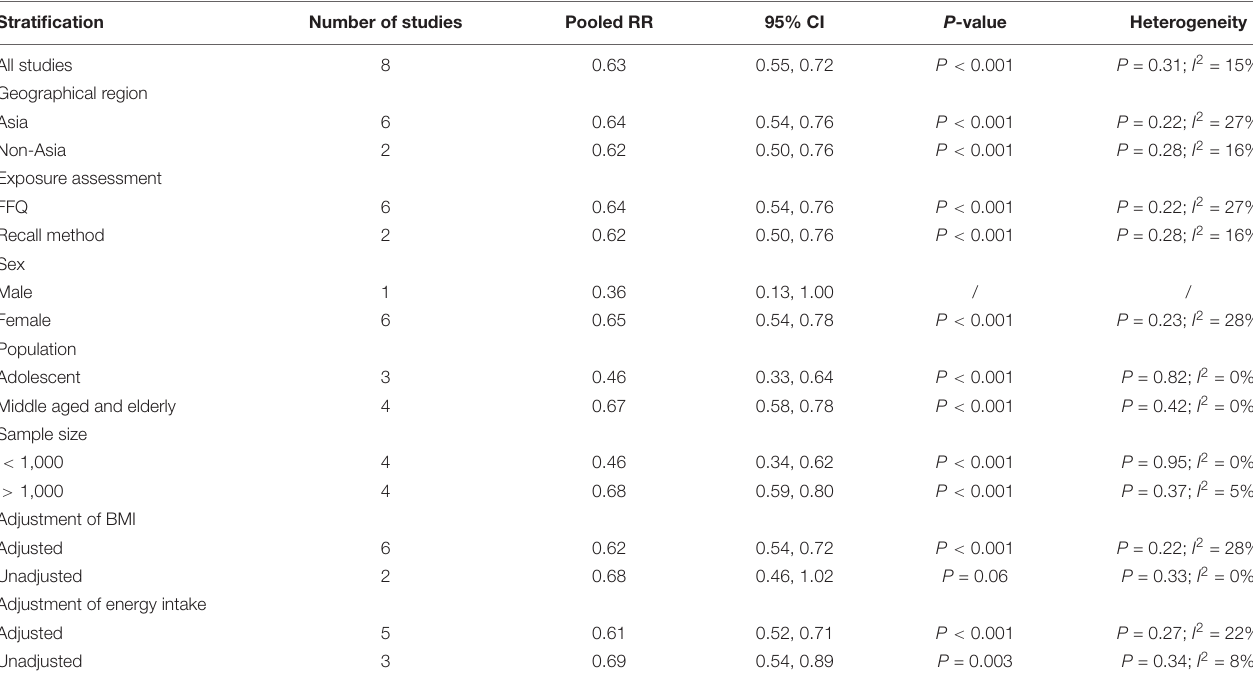
TABLE 4 | Subgroup analysis of depression for the highest vs. lowest category of dietary beta-carotene